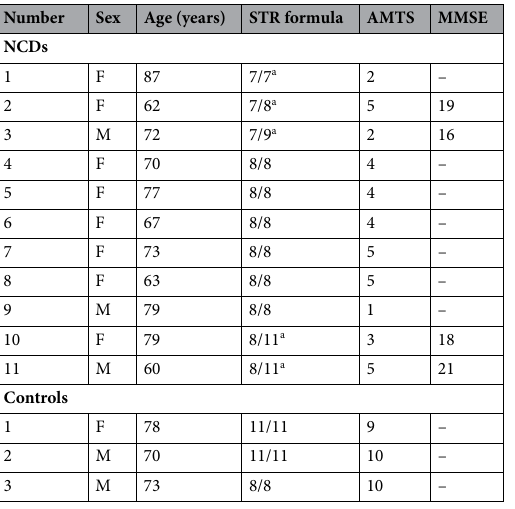
Table 1. NCD patients and controls harboring divergent genotypes (lacking the 6-repeat). F Female, M male. a Disease-only genotypes.